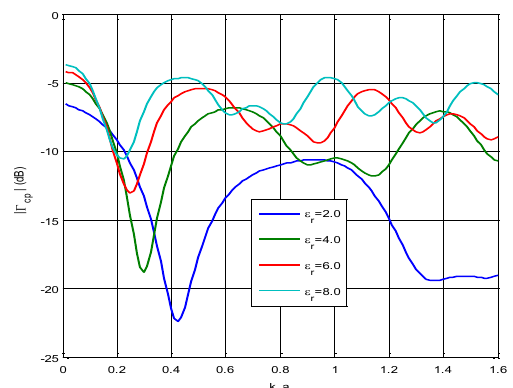
Fig. 5. Variations of the magnitudes of co-polar reflection coefficients versus k circular cylinders of radius a , with d = 2.25 cm, v = 45 o , and for different